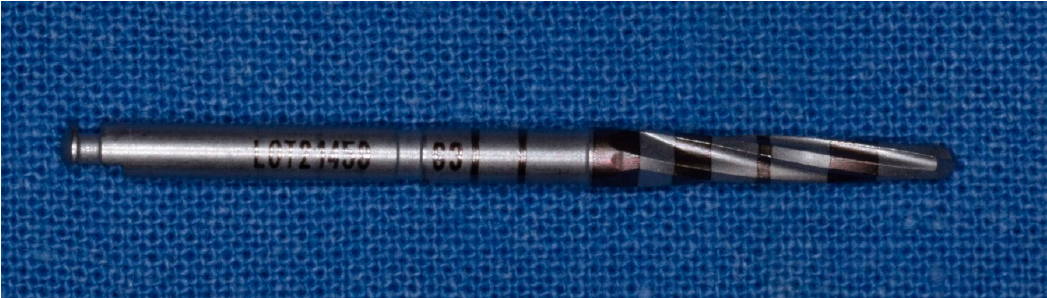
Figure 6. Second cutter with a diameter of 2.0 mm in the method “implant drilling with bone compaction instrumentation technique.”